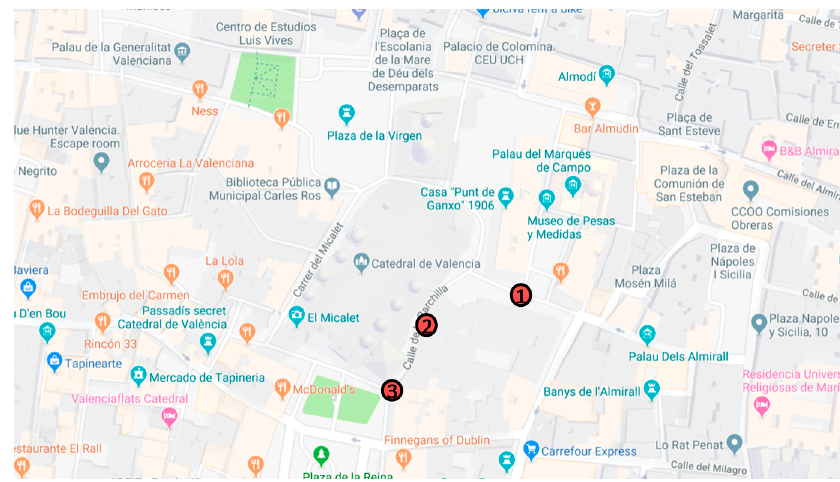
Figure 3. Position of the outside sonometers.